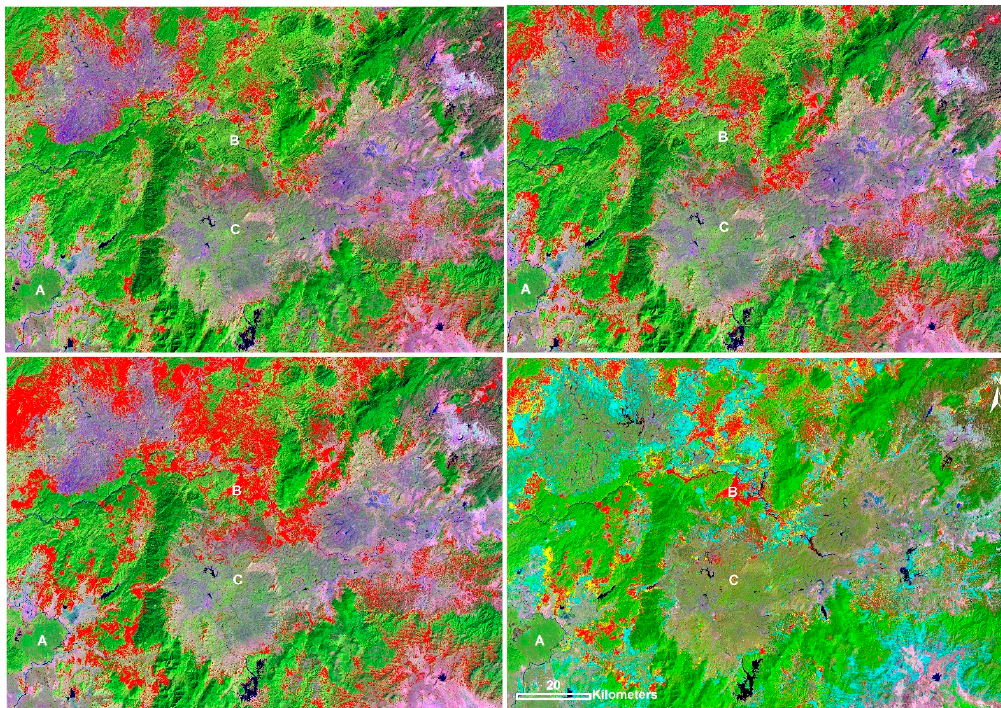
Figure 9. Images depicting forest degradation occurring over different time periods. Upper left image = Degradation changes from 2001 to 2006 (in red); Upper right image = Degradation changes from 2001 to 2010 (in red); Lower left image = Degradation changes from 2001 to 2014 (in red); Lower right image = Degradation changes by epoch, with turquoise representing changes from 2001 to 2006, yellow representing changes from 2006 to 2010, and red being changes occurring from 2010 to 2014. Areas denoted by letters A, B and C are described in the Figure 7 caption.